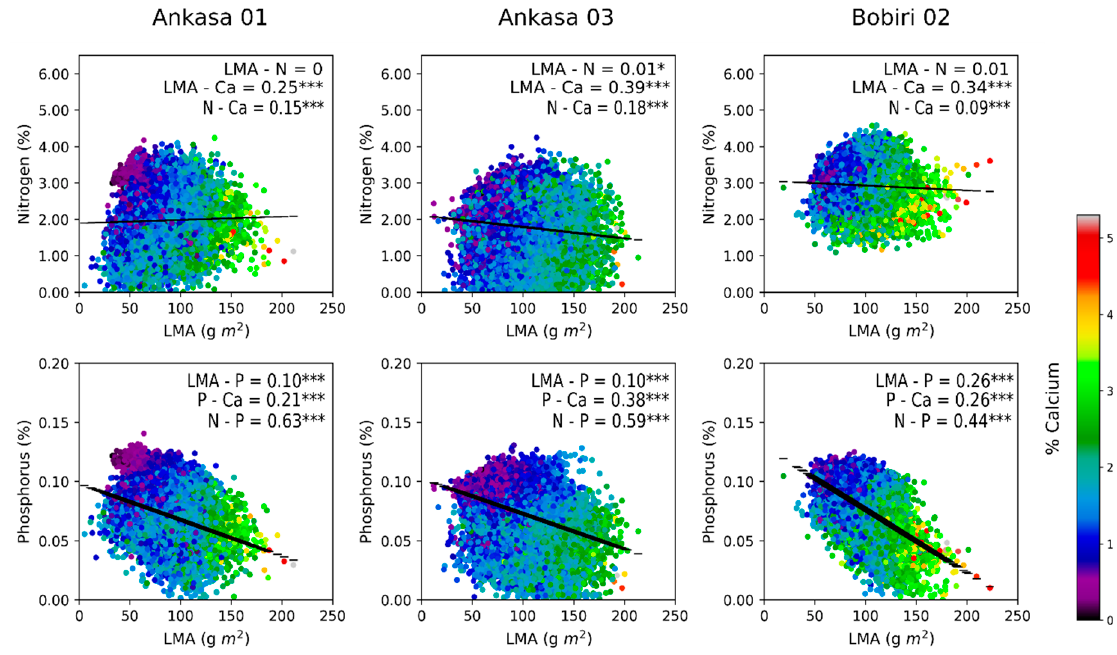
Figure 7. Relationship between LMA–N and LMA–P for each pixel of Figure 6. Colour as a function of Ca. R 2 values are shown on the graphs with the level of significance ( p ) indicated (* p < 0.10; ** p < 0.05; *** p < 0.01). n = 34789 for Ankasa 01. n = 32807 for Ankasa 03. n = 19014 for Bobiri 02. These graphs are based on the remotely sensed values, not field-collected